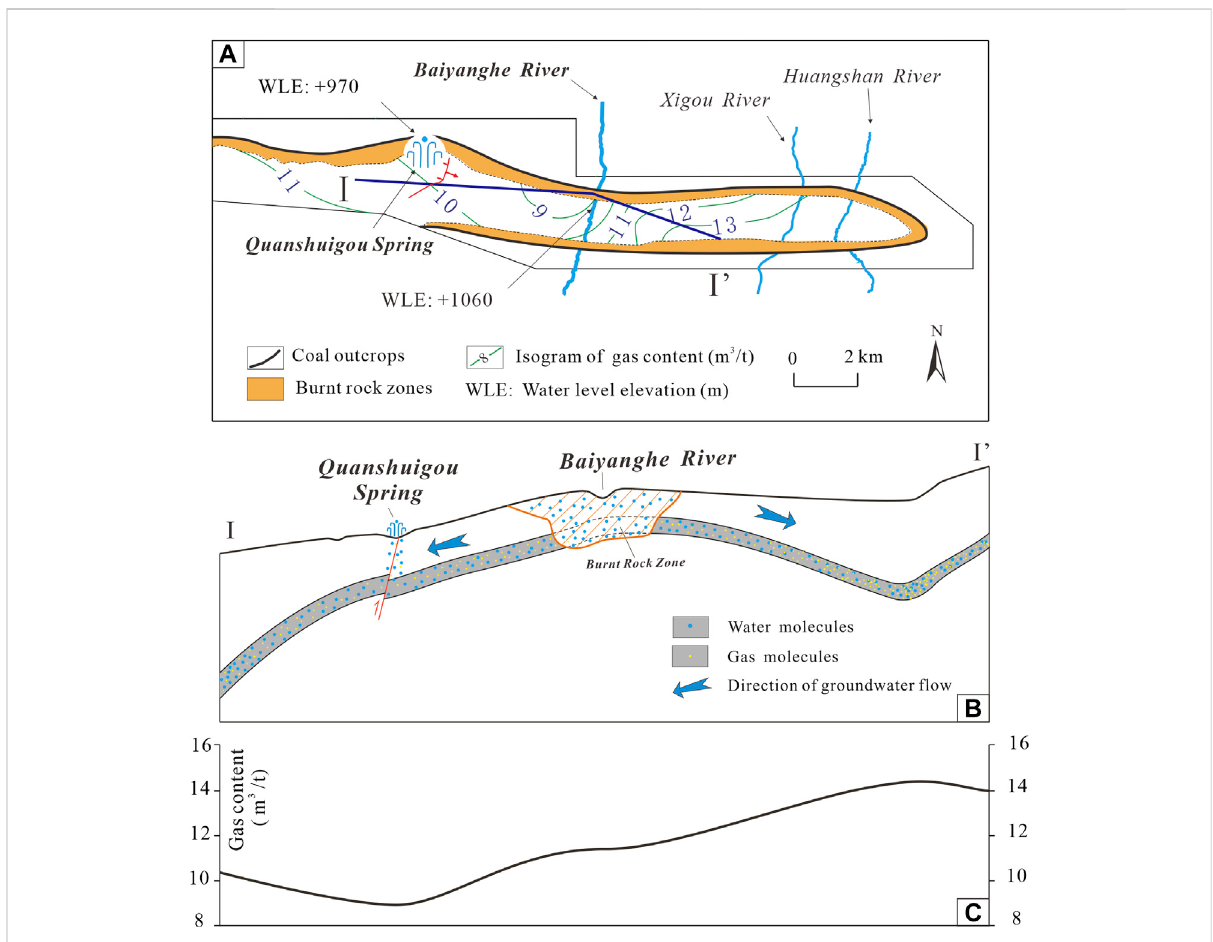
FIGURE 10 Gas accumulation model showing the effect of burnt rock zone, hydrology, biogenic gas formation and coal seam structures on gas contents. (A) -Contour map of gas content showing the distribution of geological factors. (B) -Diagram of section Ⅰ - Ⅰ ’ in diagram (A) showing migration of coalbed methane and formation water controlled by hydrogeology and tectonic structures. (C) -Variation of gas content in section Ⅰ - Ⅰ ’